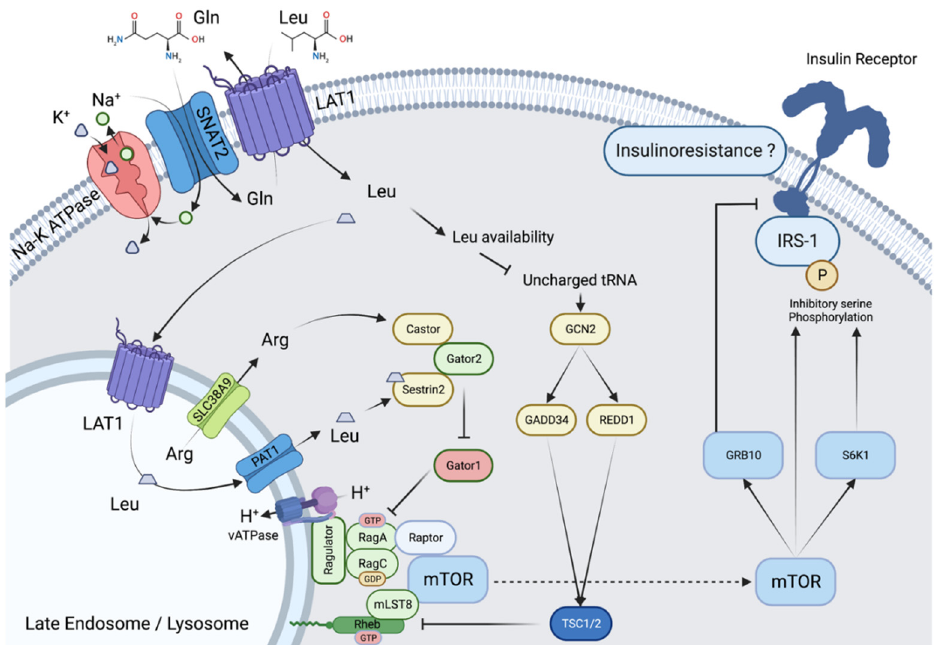
Figure 1. Activation of mTORC1 by leucine in muscle cells. Activation of mTORC1 in muscle cells involves (i) counter-transport in exchange with glutamine and transport into endosomes, localized near the cell membrane, via LAT1, (ii) increased leucyl-tRNA charging inhibiting the GCN2 pathway, (iii) leucine efflux from the endosome via PAT1 involving inward proton transport via vATPase, (iv) interaction of leucine with the protein sestrin2, lifting the inhibitory effect of the GATOR1/2 complex on RAG-GTPases and allowing (v) localization of mTORC1 to the endosome and its activating interaction with Rheb.